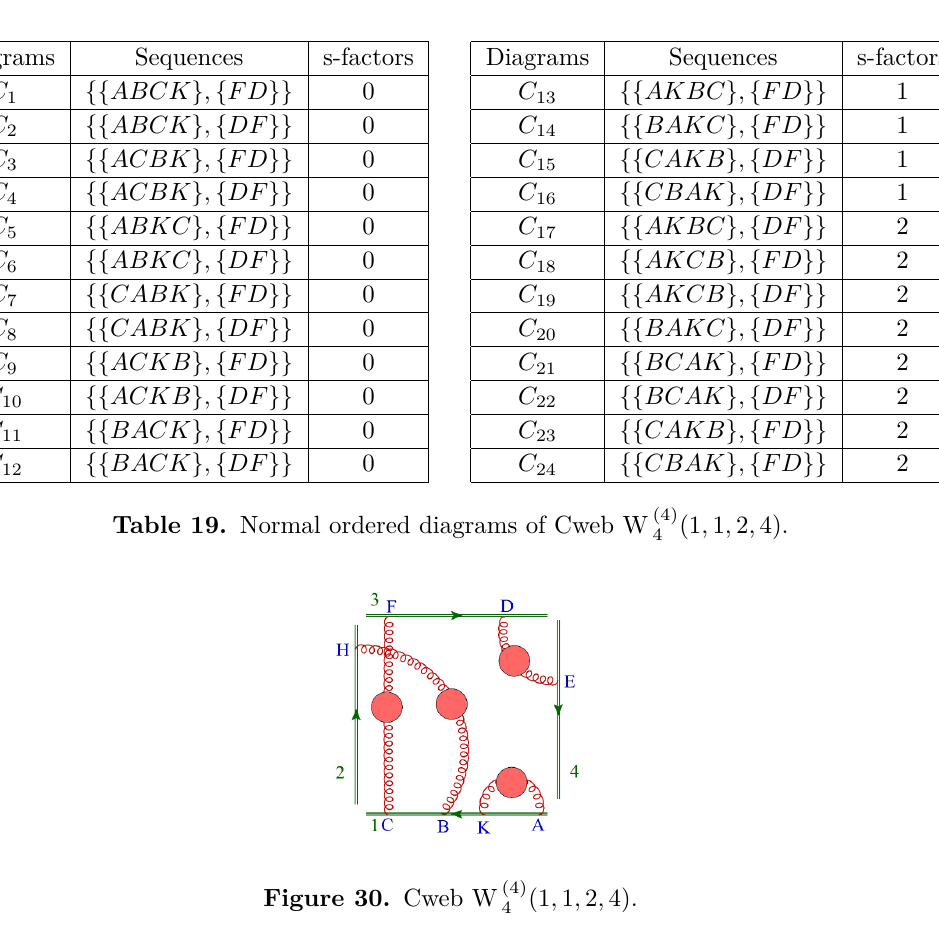
Figure 30. Cweb W (4)